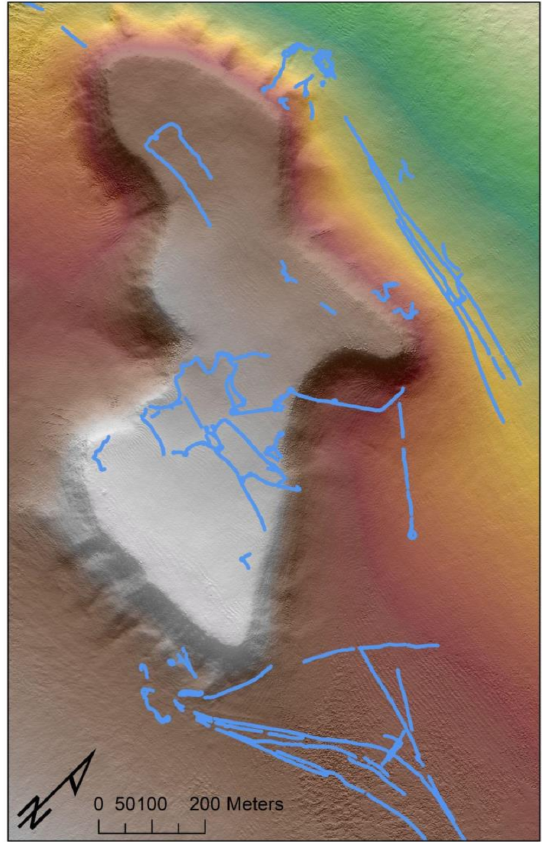
Figure 13. Three kites clustered on Mesa #2 (“Tell A”). One enclosure utilizes the top of the mesa, while the other two wrap around the northern and southern